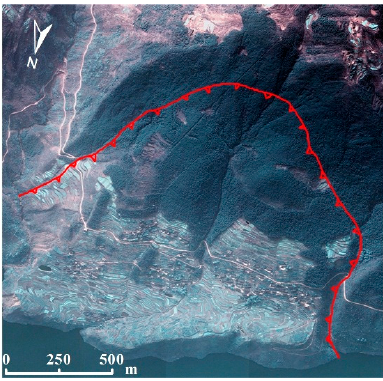
Figure 2. The Fanjiaping landslide identified by the aerial photographs of the landslide. A total of eleven layers were derived as inputs from the satellite data and thematic maps (Table 1). Table 1. Input layer information in this study.